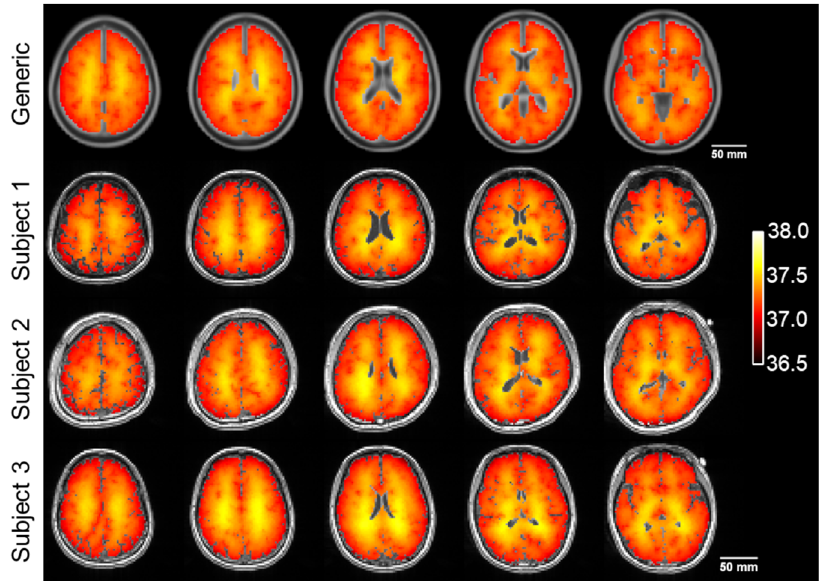
Fig. 5 Comparison of model-predicted brain temperature maps generated using generic non-subject-speci fi c and subject-speci fi c input data. The generic model-predicted temperature map used non-subject-speci fi c atlas-based input data. For each subject, model-predicted temperature maps were generated using subject-speci fi c magnetic resonance input data. While all model-predicted maps show higher temperatures in white matter compared to gray matter, temperatures varied spatially between individual subjects. The temperature color bar ranges from 36.5 to 38.0 °C. Scale bars are 50 mm and all the images from subject-speci fi c data are on the same